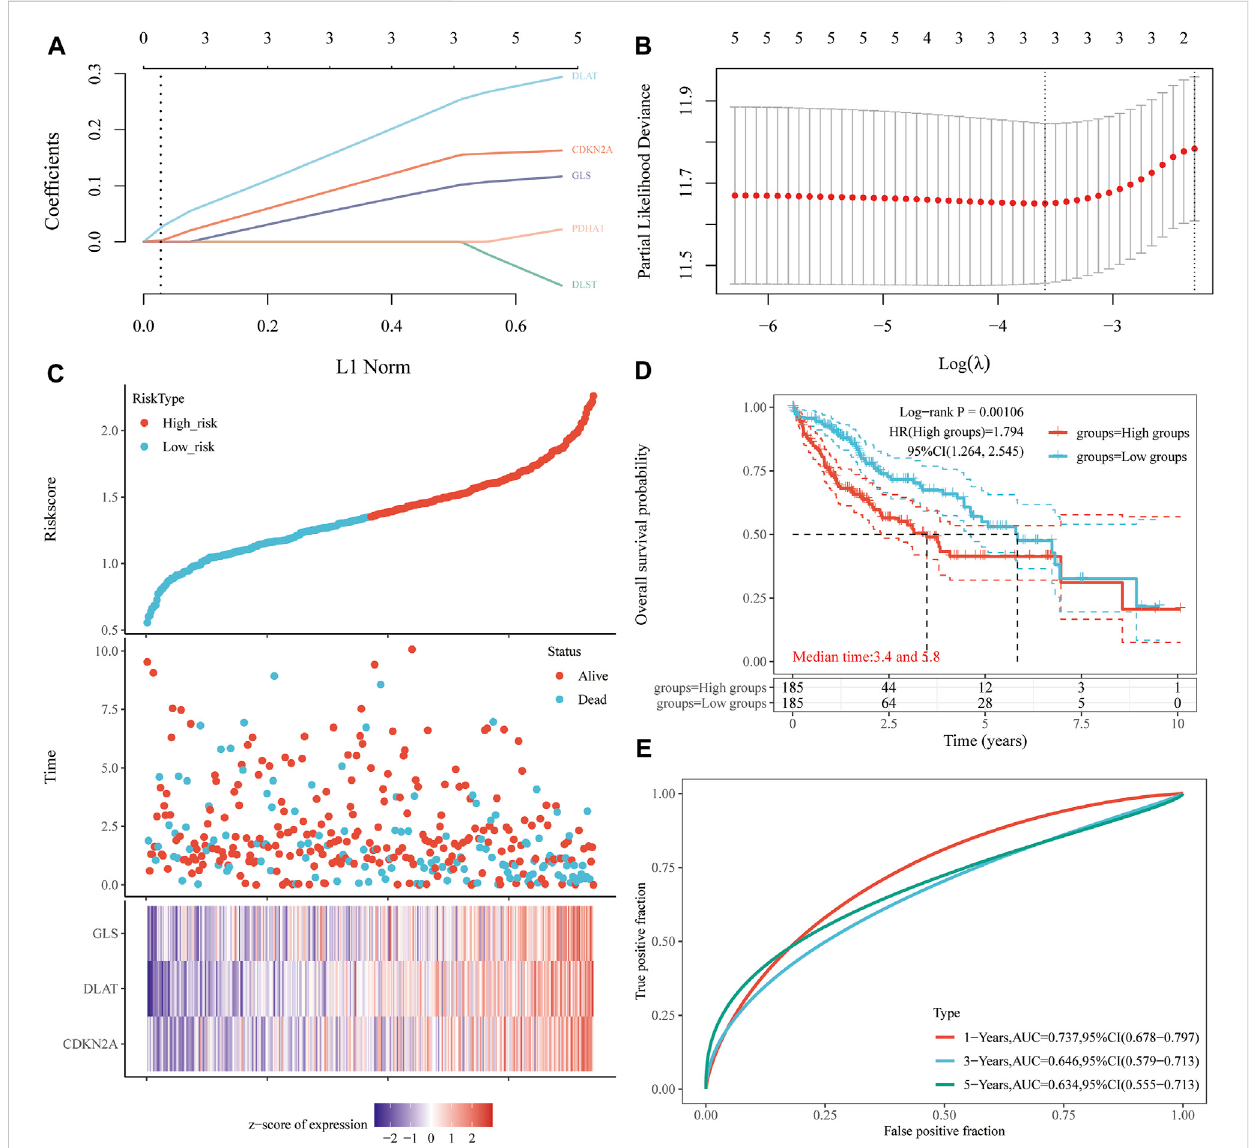
FIGURE 6 ConstructionofaprognosticCRGmodel. (A) LASSOcoef fi cientpro fi lesofprognosticCRGs, (B) Plotsoftheten-foldcross-validationerrorrates. (C) Distribution ofthe riskscore, survivalstatus, and theexpressionofprognostic CRGs inHCC. (D,E) OS curves ofHCC patients inthe high-/low-risk group and the ROC curve for measuring the predictive